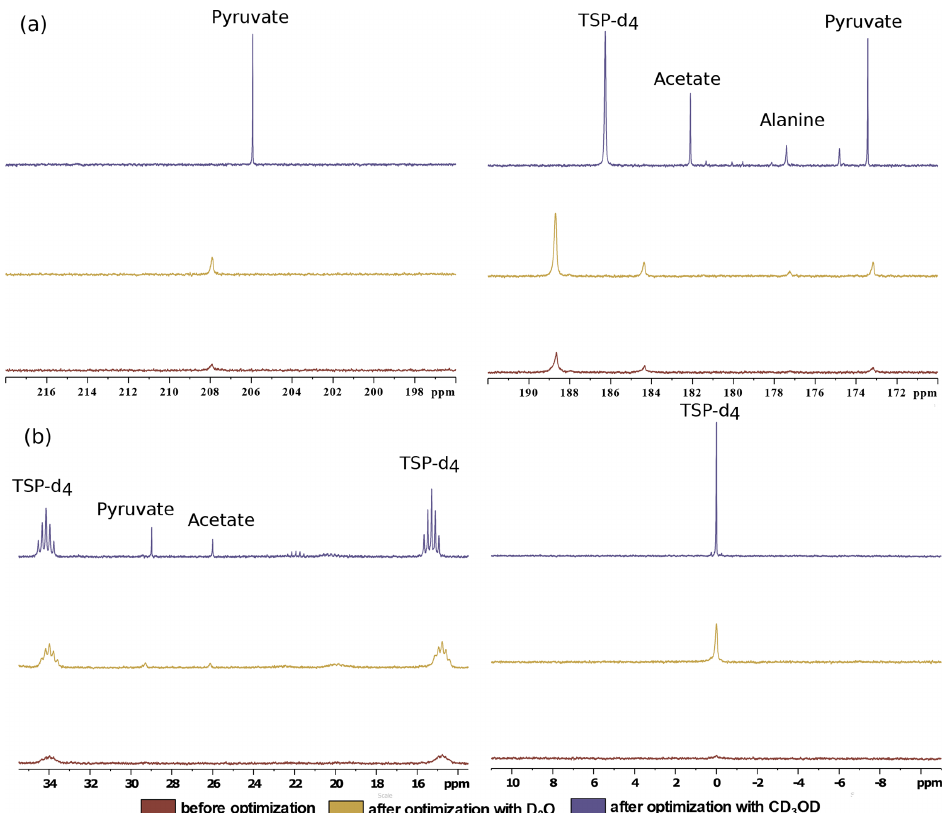
Figure 8. Comparison of 13 C– { 1 H } spectra of metabolites before and after optimization in the (a) quaternary 13 C region and (b) protonated 13 C region using two dissolution solvents.